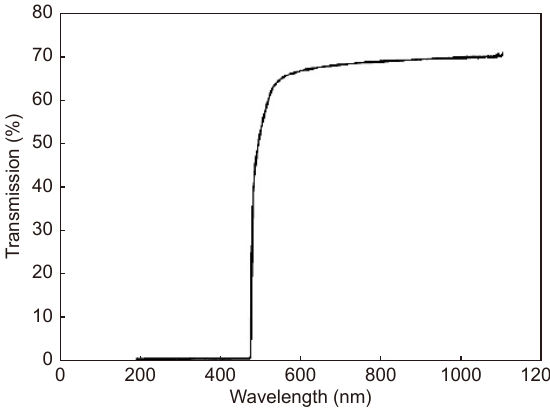
Fig. 3 | The external transmission of ZnSe measured with a spectrophotometer, showing that the cut-off λ ~ 460 nm, E b = 2.7 eV and high transparency in the